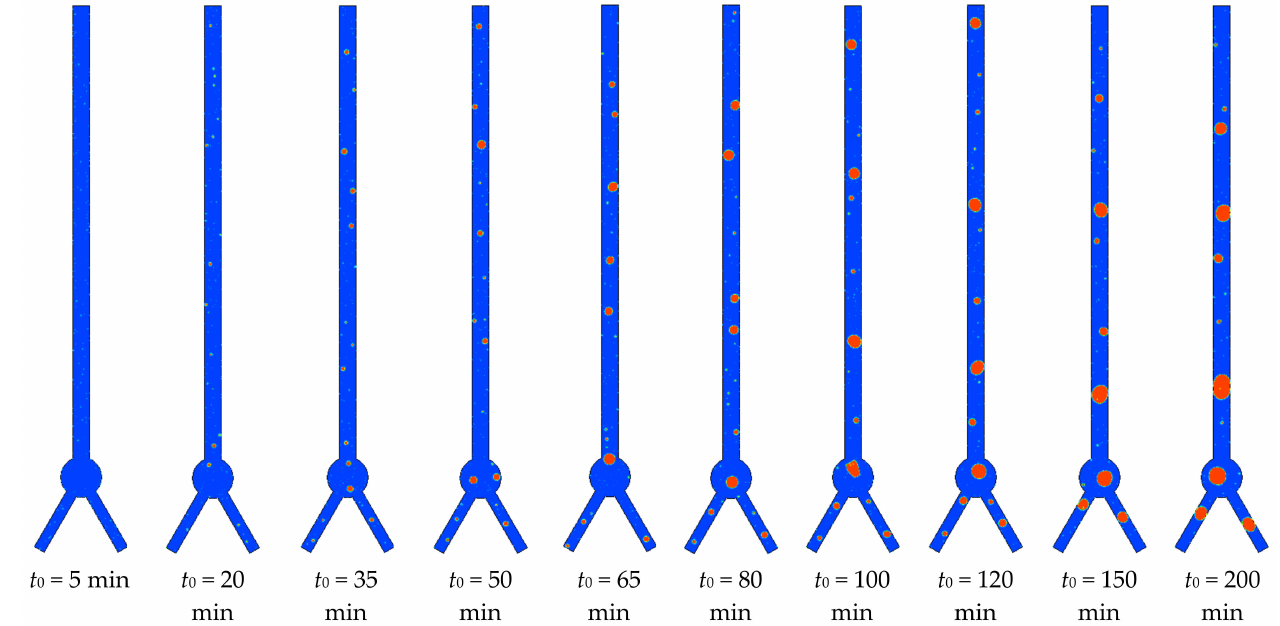
Figure 4. Bubble generation and distribution inside delivery tube under 0 g 0